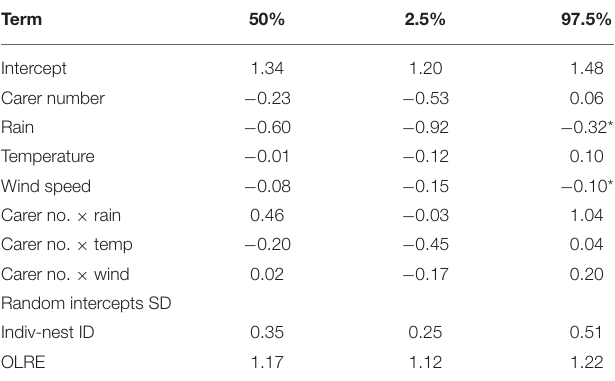
TABLE 1 | Phenological, meteorological, and social effects on the provisioning rate of dominant breeding males. Term 50%